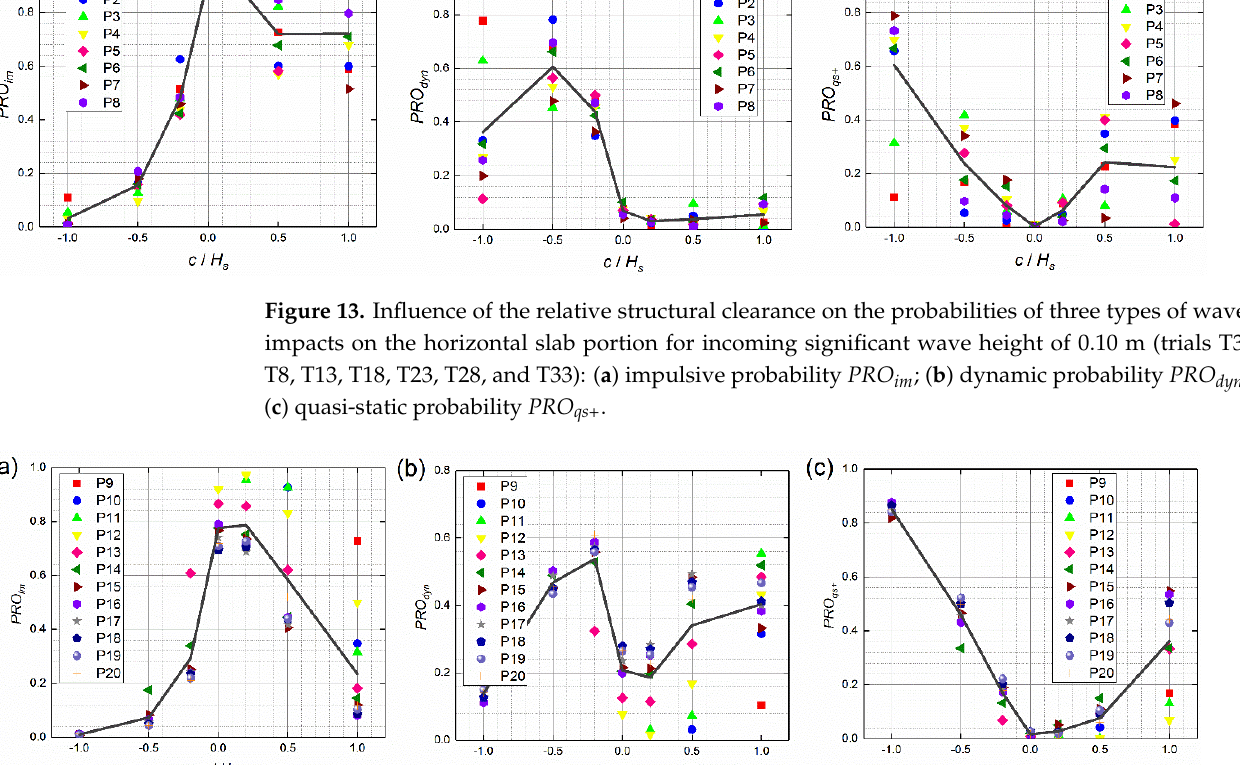
Table 5. Classification of dominant wave impact type on relative clearance.